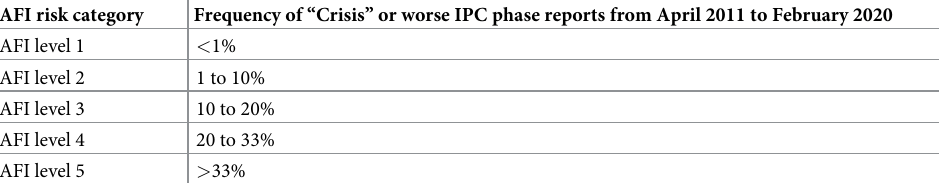
Table 1. The scheme for classifying AU2 in Sub-Saharan Africa in to different levels of Acute Food Insecurity (AFI)